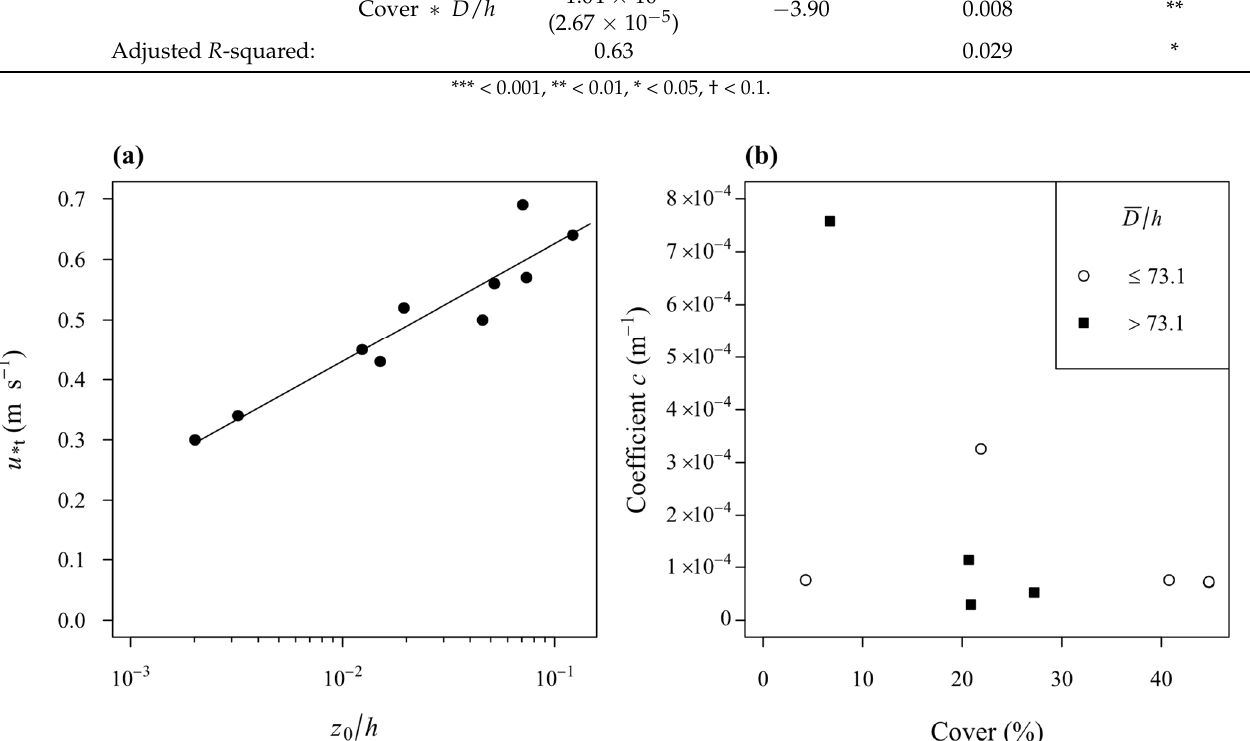
Figure 7. Relationship between 𝑧 (cid:2868) /ℎ and cover. The points were divided into high and low catego- ries based on the average of 𝐷(cid:3365)/ℎ .